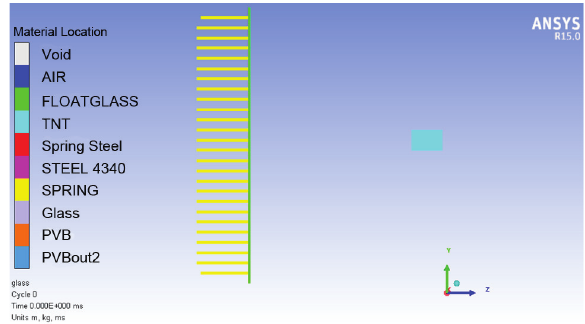
Fig. 4. Lateral face of one-layer laminated glass with spring